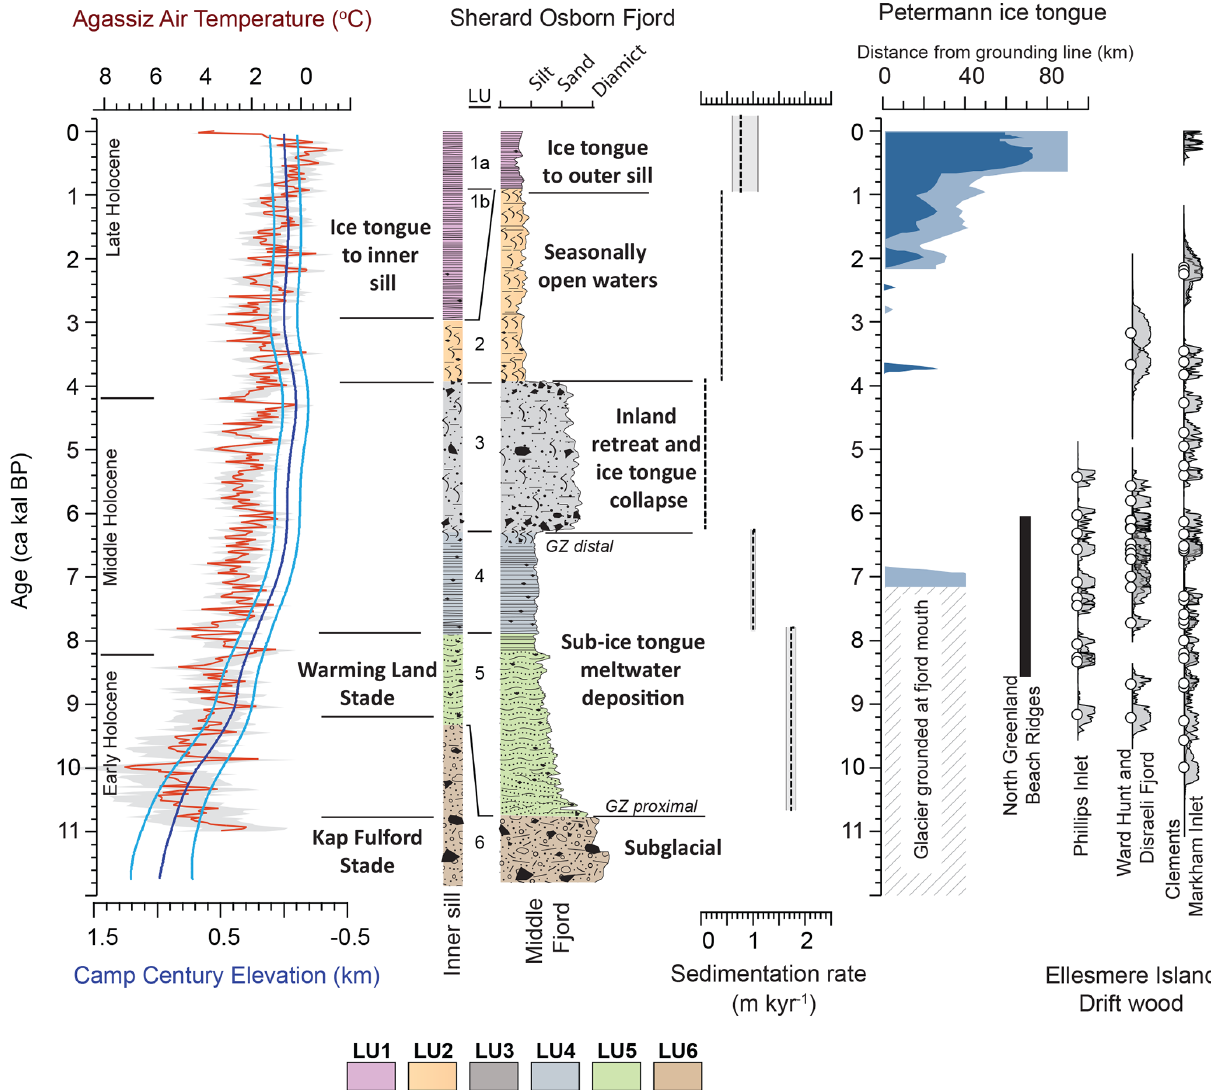
Figure 10. Representative lithostratigraphic column and environmental interpretations for the sedimentary cover of the inner sill and middle fjord. Approximate linear sedimentation rates are provided for the middle fjord (station 7, Fig. 2) using the derived unit boundary ages and their uncertainty (Table 3). The interpreted lithostratigraphic column is shown alongside the Agassiz air temperature reconstruction and elevation changes in the GrIS at Camp Century (Lecavalier et al., 2017); the reconstructed extent of Petermann Glacier ice tongue (Reilly et al., 2019); the period of beach ridge formation along the north coast of Greenland indicating the absence of perennial landfast ice (Möller et al., 2010); and driftwood delivery to northern Ellesmere Island (England et al., 2008). Radiocarbon dates from England et al. (2008) were recalibrated using